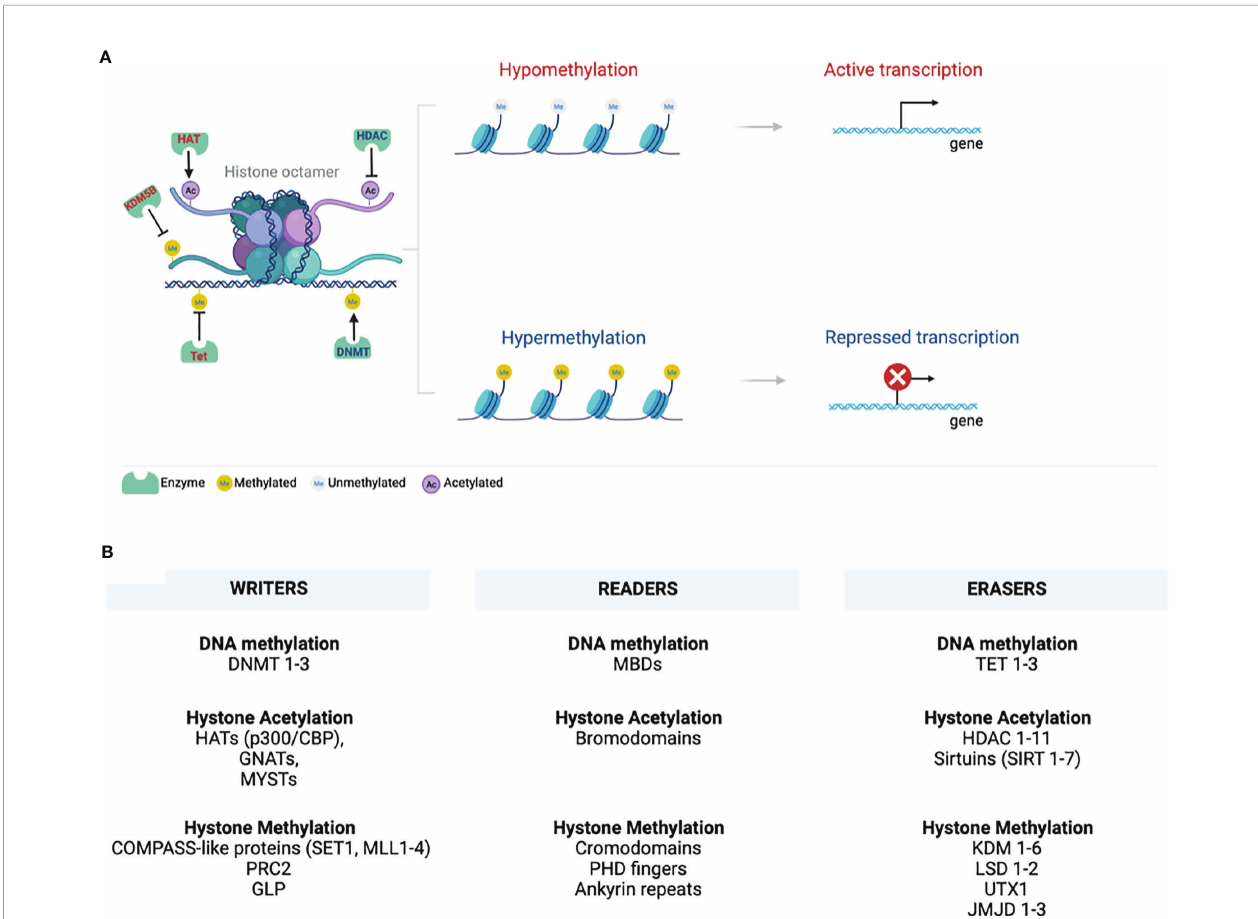
FIGURE 1 | Chromatin structure. (A) A 147bp DNA wraps around the histone octamer with two copies of each of the histones H2A, H2B, H3, and H4. Various epigenetic mechanisms that modify chromatin, such as DNA methylation and histone modi fi cations, are highlighted. DNA and histone methylation collaborate with different modifying enzymes and creates a tightly packed chromatin and suppress gene transcription by preventing the transcription machinery from binding DNA. Histone acetylation perturbs structural electrostatic interactions between the DNA and histones, resulting in the less compact structure of chromatin structure. This allows DNA access by transcription factors that promote gene transcription. (B) Writing, erasing, and reading chromatin methylation markers are highlighted. These mark various sites on the tail and globular domains of histones. Writers and erasers are methyltransferases and demethylases, respectively. These are recognised by distinct effector proteins called readers. (Created with BioRender.com) ac, Acetylation; DNMT, DNA methyltransferase; GLP, G9a-like protein; GNATs, Gcn5-related N-acetyltransferases; HATs, Histone acetyltransferases; HDACs, Histone deacetylases; JmjC, Jumonji C; KDM, Histone lysine demethylases; LSD, Lysine-speci fi c demethylases; MBDs, Methyl-CpG binding domains; me, Methylation; MLL, Mixed-lineage leukaemia; PHD - Plant homeodomain; PRC2, Polycomb repressive complex 2; p300/CBP, p300 and cyclic AMP response element-binding protein; SET1, Suppressor of variegation 3 – 9, Enhancer of Zeste, Trithorax 1; SIRT, sirtuins; TET, Ten-eleven translocation; UTX1, Ubiquitously transcribed tetratricopeptide repeat, X chromosome